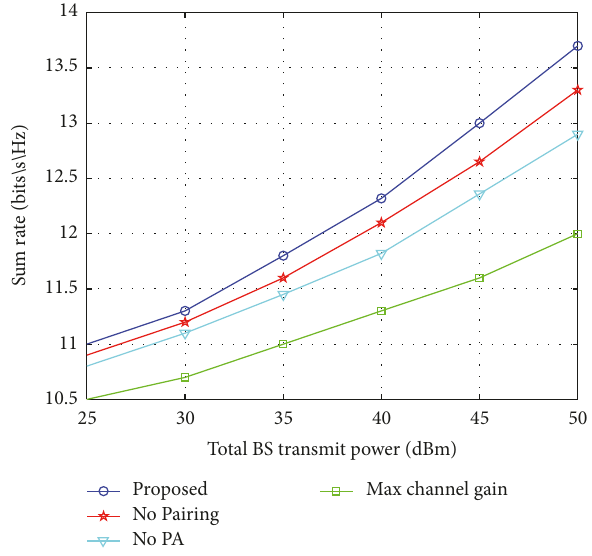
Figure 4: Operator’s profits versus different number of users.